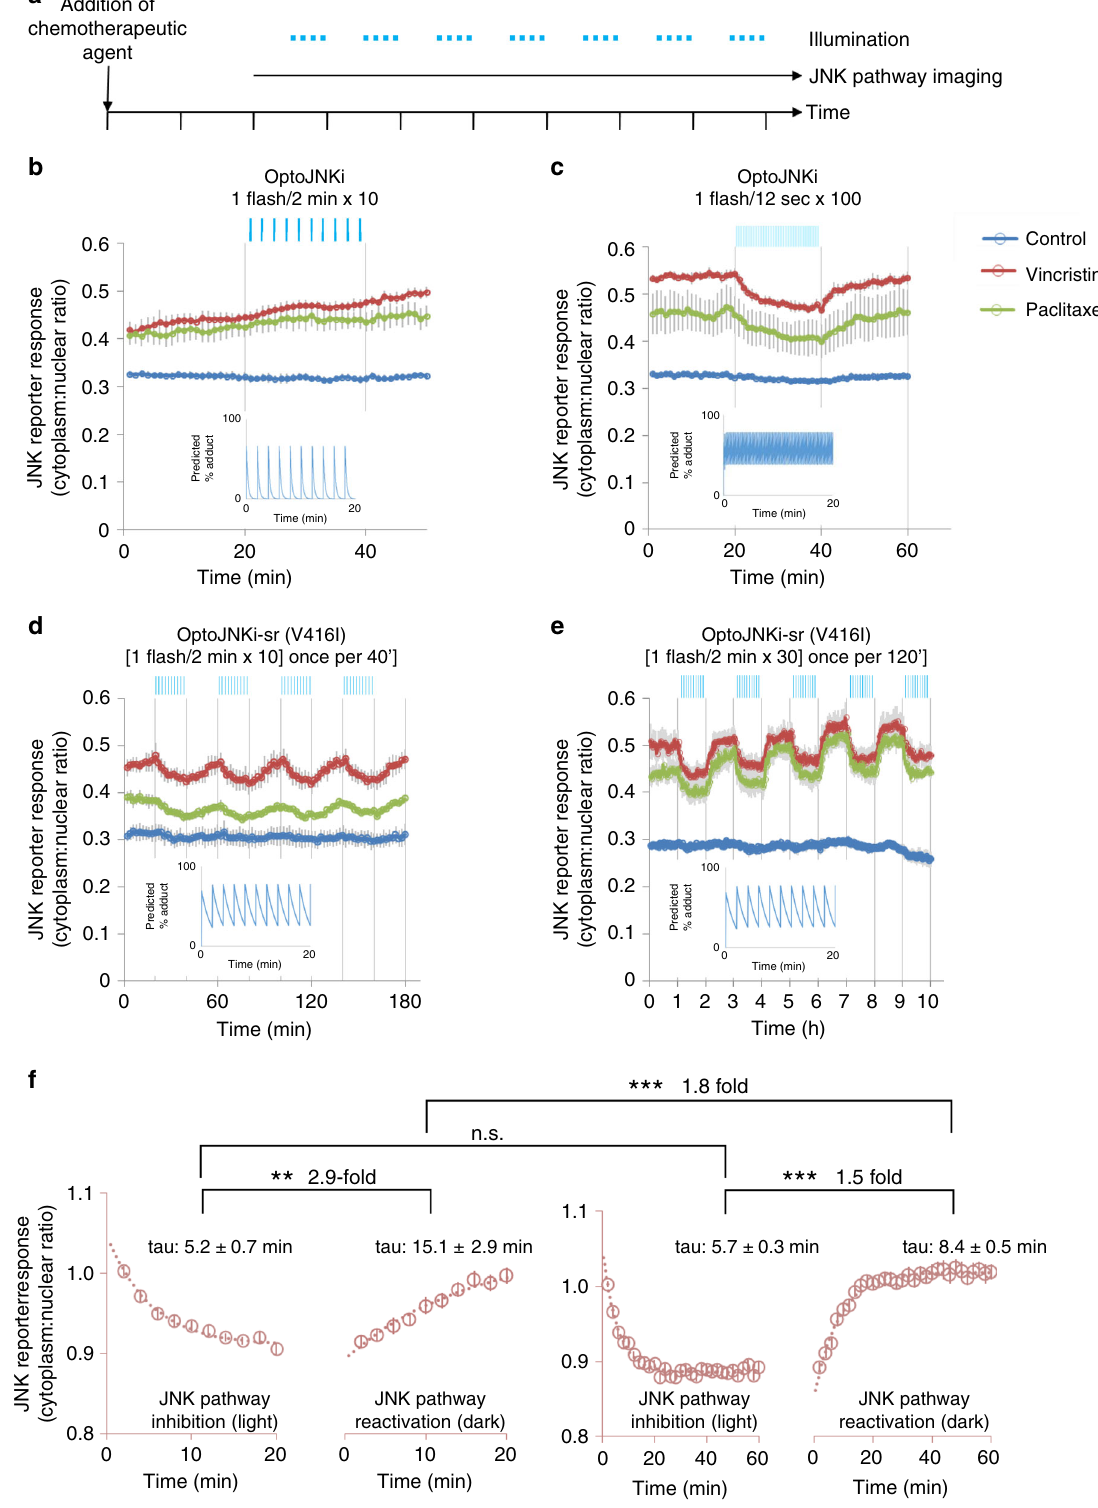
ditions and implementation of mutants, reducing photon dose up to tenfold while increasing experimental throughput